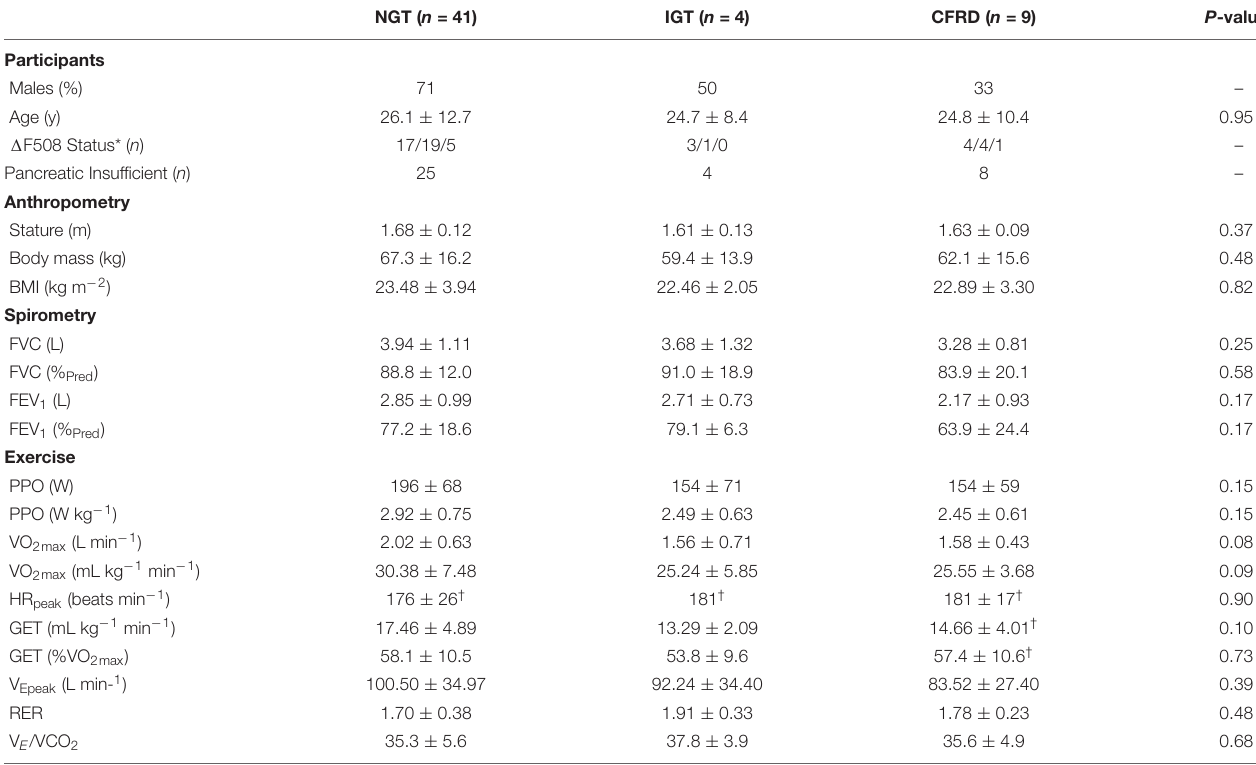
TABLE 2 | Participant characteristics including anthropometry, pulmonary function, and exercise -based outcomes at one-year follow-up